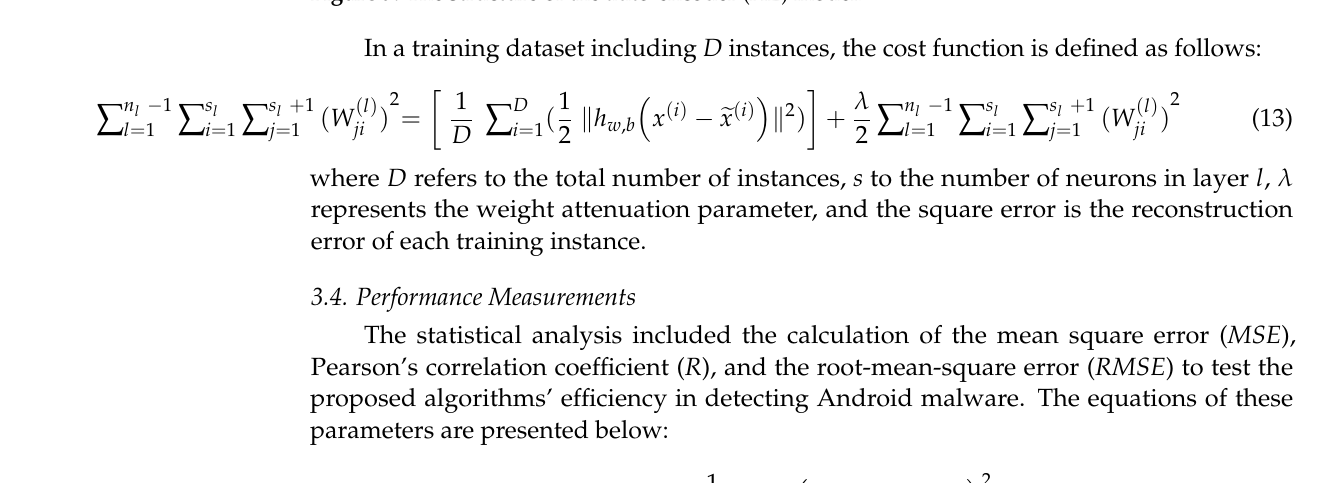
Figure 9. The structure of the auto-encoder (AE)